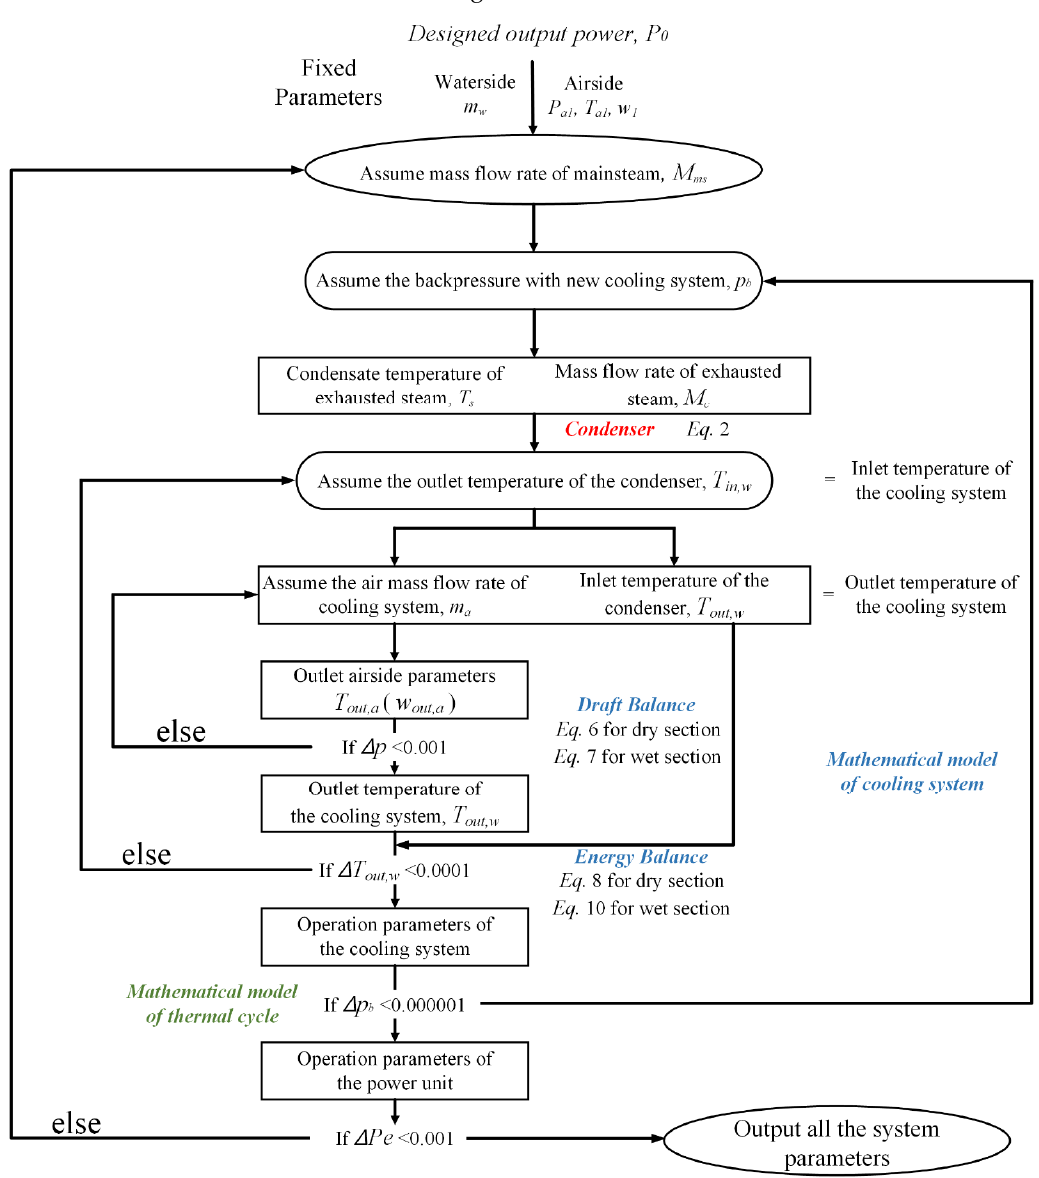
Figure 2. Flowchart of the iterative loop.